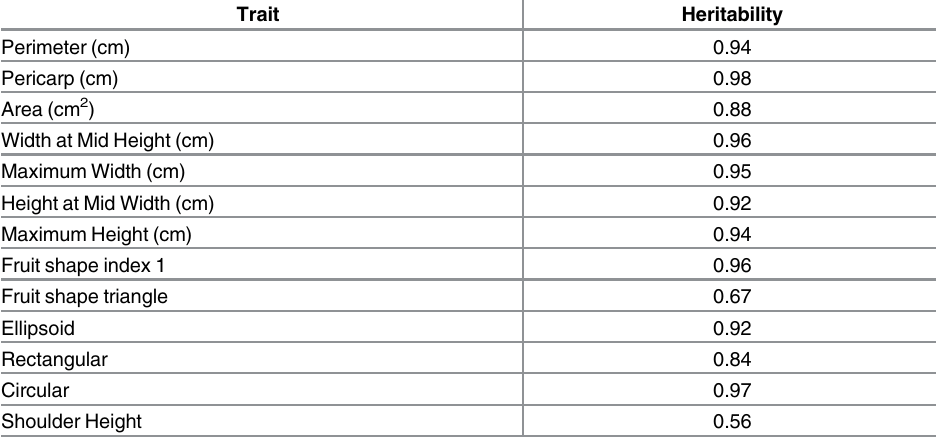
a pericarp thickness (cid:1) 0.30 (Table 5). Moderate differentiation (F between peppers with a pericarp thickness of 0.05 to 0.10 and peppers with a pericarp thickness (cid:1) 0.30. These data, combined with pericarp differences among continents, suggest that the Table 3. Broad sense heritability of fruit phenotypic